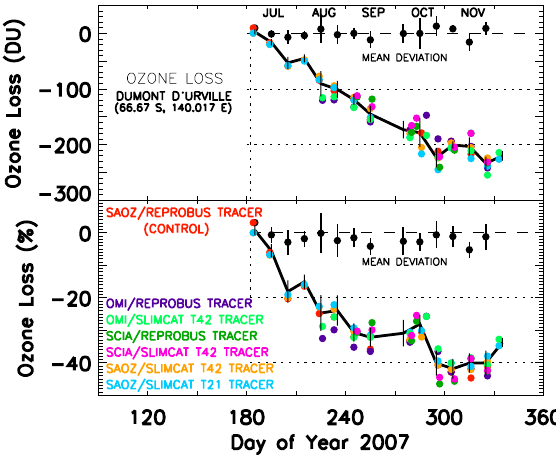
Fig. 4. Vortex averaged (ten-day mean) individual ozone loss esti- mated at the ground-based stations in the Antarctic using the passive method (top: DU, bottom: percent). The loss in absolute unit (DU) is estimated as ozone meas -tracer and its relative loss (%) is com- puted as 100 × (ozone meas -tracer)/tracer. The black thick lines rep- resent the mean and the error bars represent the standard deviation from the mean. The observations from Kerguelen, a mid-latitude station, are not included in the average, shown with “x” marks. The vertical dotted lines represent the different phases of ozone loss pro- cesses in the Antarctic as marked in the colour shades (see text), while the horizontal dotted lines represent 50, 150 and 250DU and 15, 30, 45 and 60% of ozone loss. Some stations start the win- tertime observation in August or September. The ozone loss onset varies with respect to sunlit latitudes and therefore, the onset period depends on co-ordinates of the stations. Thus, the onset and rapid loss phases are clustered together with dashed lines.